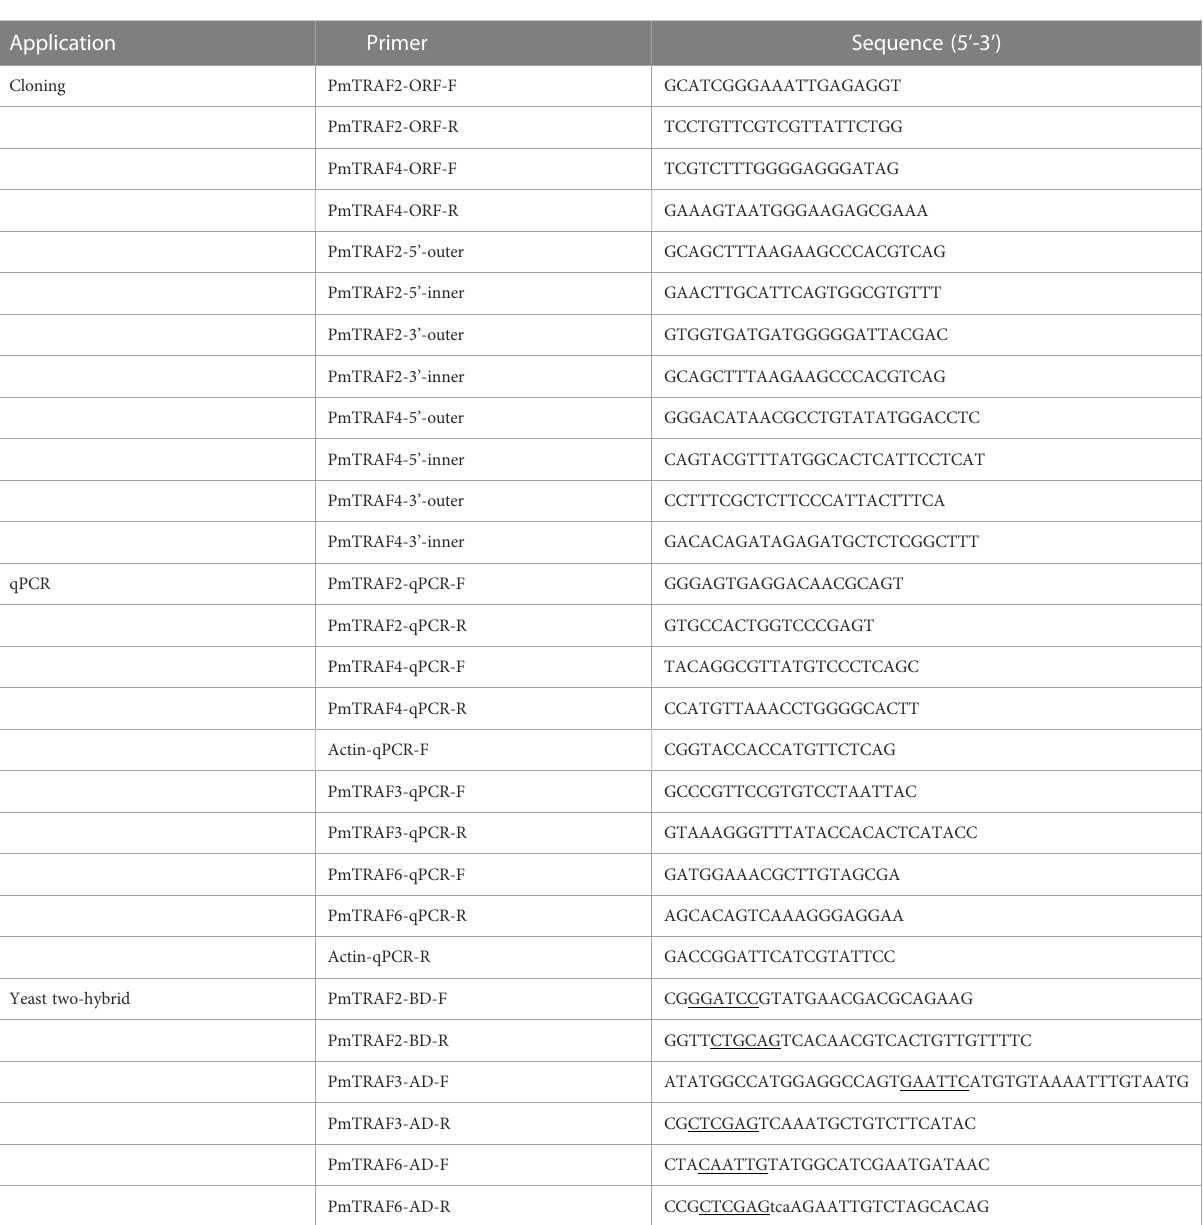
TABLE 1 Primer sequences were used in this